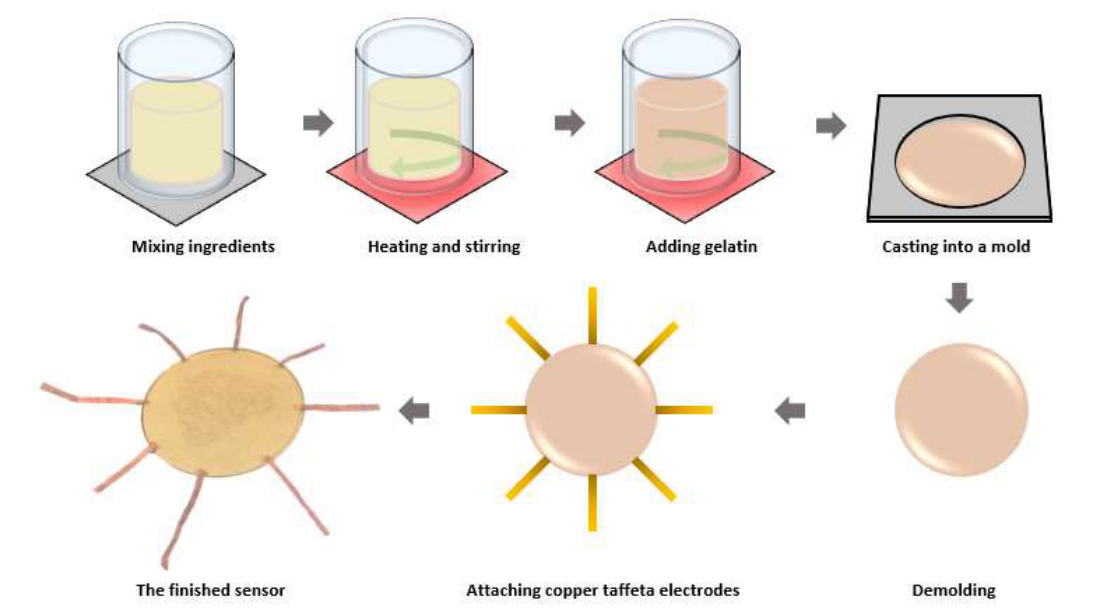
Figure 3. The fabrication procedure of the hydrogel-based touch sensor.